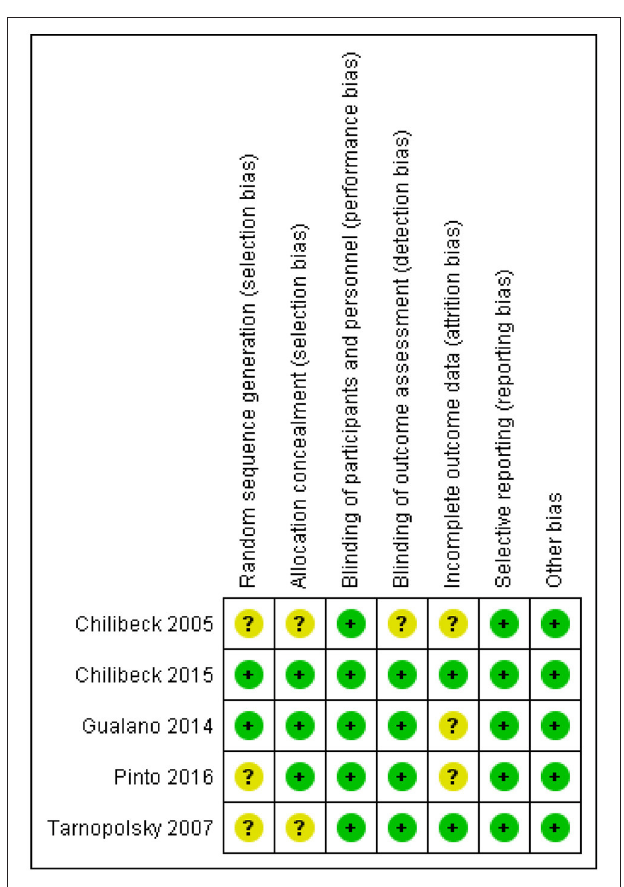
FIGURE 2 | Risk of bias